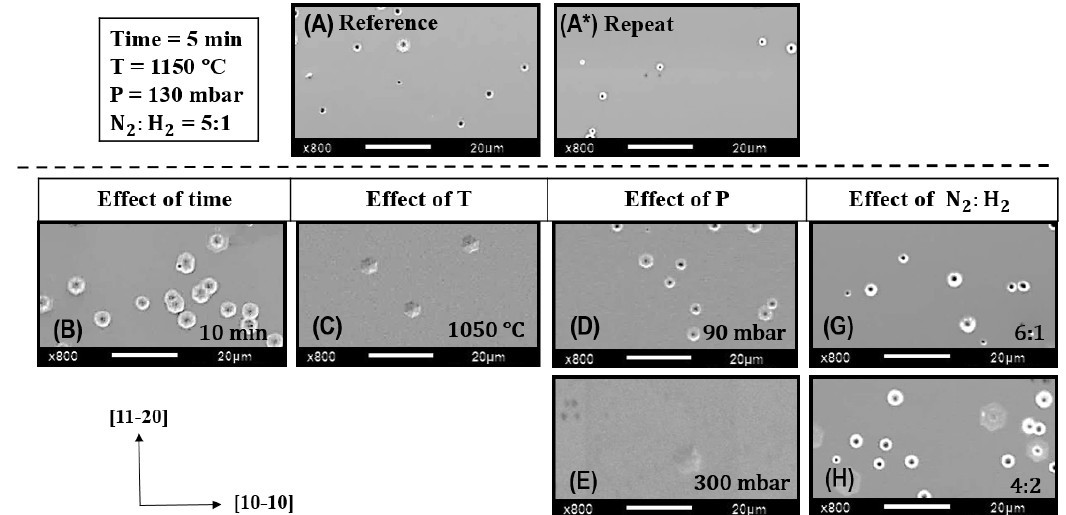
Figure 3. SEM plan-view images of the same samples as shown in Figure 2. The etching parameters of the reference sample ( A ), and a reproduced sample ( A* ), under the same etching conditions are shown in the first row. Correspondingly, one parameter is altered for each sample with respect to the reference sample as ( B ) 10 min in-situ etching time, ( C ) temperature of 1050 ◦ C, ( D ) pressure of 90 mbar, ( E